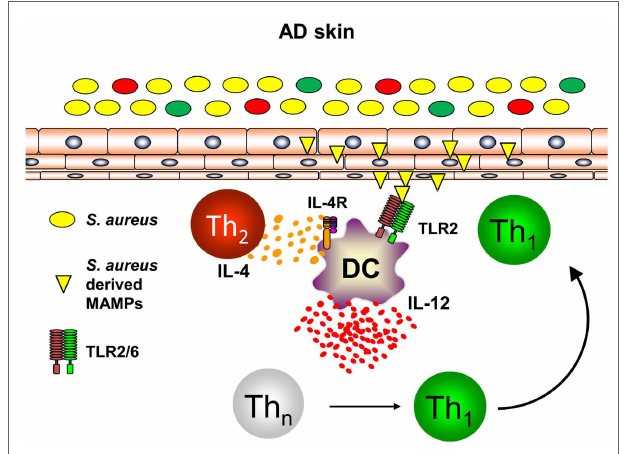
FiGURe 2 | Dual activation of skin-resident DC by iL-4 and TLR2 ligands promotes iL-12 expression and Th1 polarization . In atopic dermatitis skin, Th2 cells secreting IL-4 are abundantly present. Skin-resident DC are activated by S. aureus derived TLR2 ligands (lipoproteins, lipoteichoic acid) in an IL-4 rich environment leading to DC maturation and enforced IL-12 secretion by combinatorial activation of TLR2- and IL-4R-signaling while IL-10 production is markedly attenuated. As a consequence in the local lymph nodes, naïve T helper cells are preferentially polarized into a Th1 phenotype promoting long-lasting cutaneous inflammation after homing to atopic dermatitis